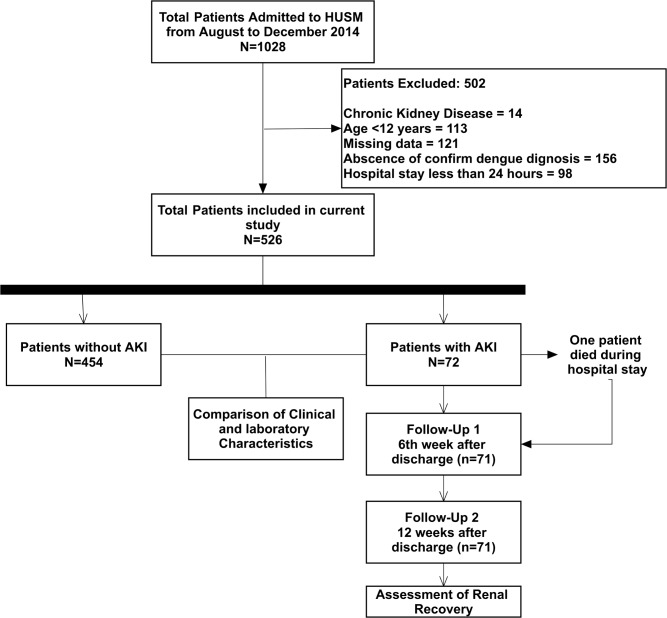
Study flow process.